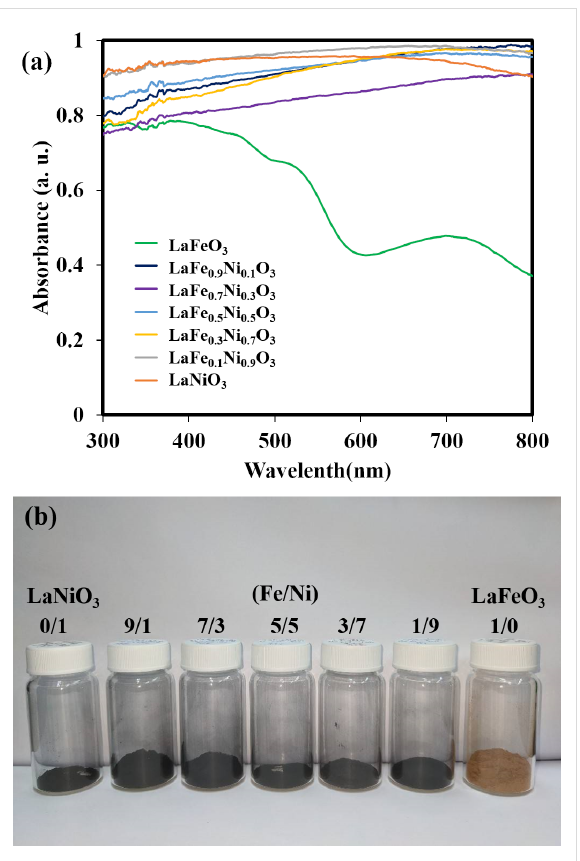
Figure 5: (a) The DRS spectrum and (b) the pictures of samples with various Fe/Ni doping